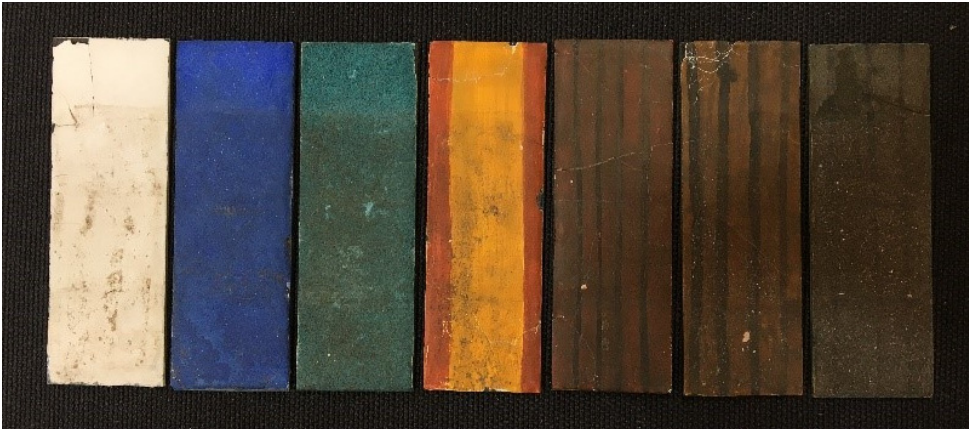
Figure 12. 5a set after cleaning tests using best conditions. Not soiled area on the top.